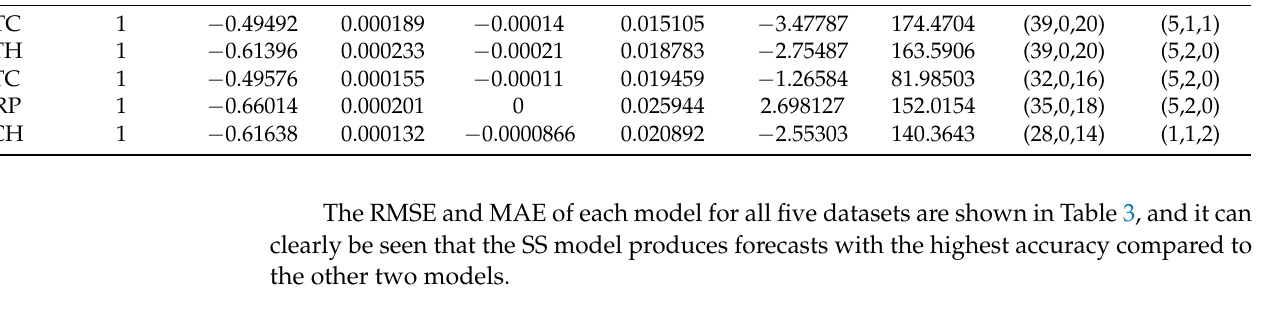
Table 3. RMSE and MAE of predicted volatility of BTC, ETH, LTC, XRP and BCH 1